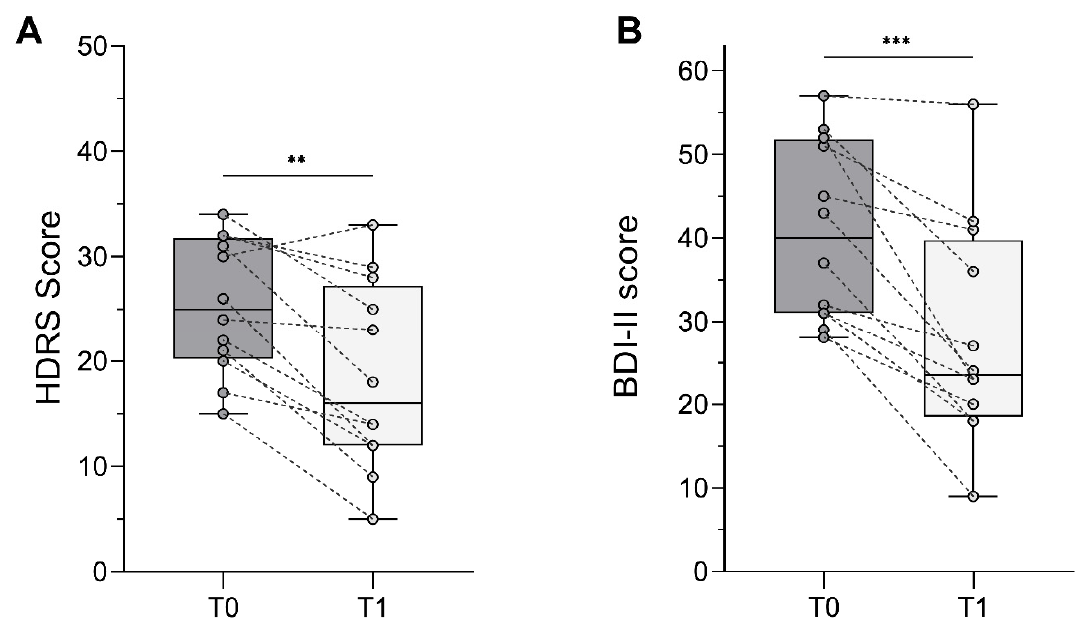
Figure 3. Effect of combined bilateral frontal plus bilateral cerebellar tDCS on depressive symptoms. Boxplots show decrease in Hamilton Depression Rating Scale (HDRS) score ( A ) and Beck Depression Inventory-II (BDI-II) score ( B ) after tDCS. Dots represent individual cases; dashed lines connect T0 (pre-stimulation) and T1 (post-stimulation) scores of the same subject. Asterisks denote statistically significant differences (** = p < 0.01, *** = p <